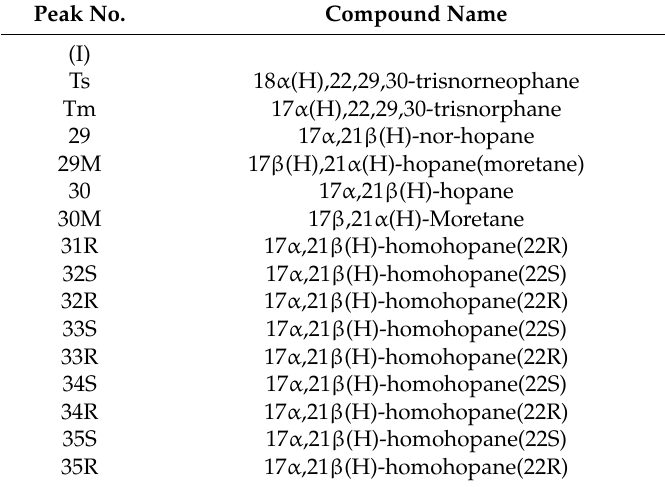
Table A1. Peak assignments for M/z191(I) and M/z217(II) mass fragmentograms of saturated hydrocarbon fractions. Peak